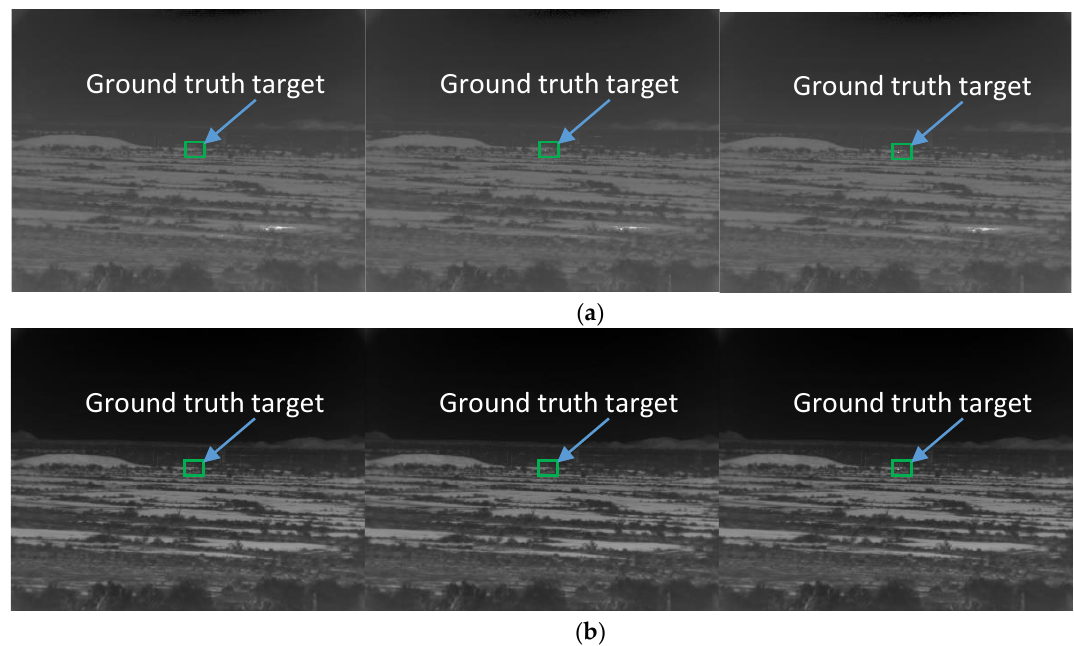
Figure A9. Three frames from 4500 m for Approach 1 and 3a. ( a ) Approach 1; ( b ) Approach 3a.